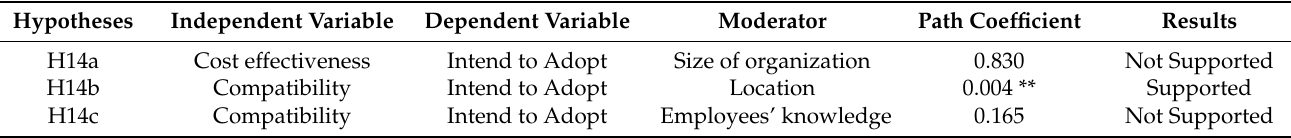
Table 6. Hypothesis tests for the moderating